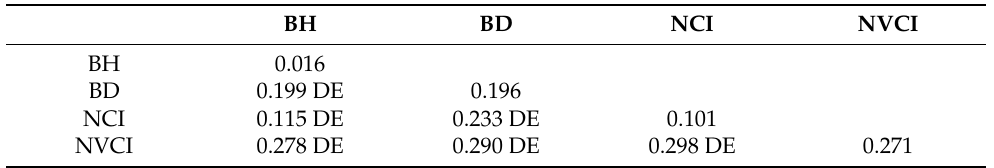
Table 5. Results of Geo-Dector interaction